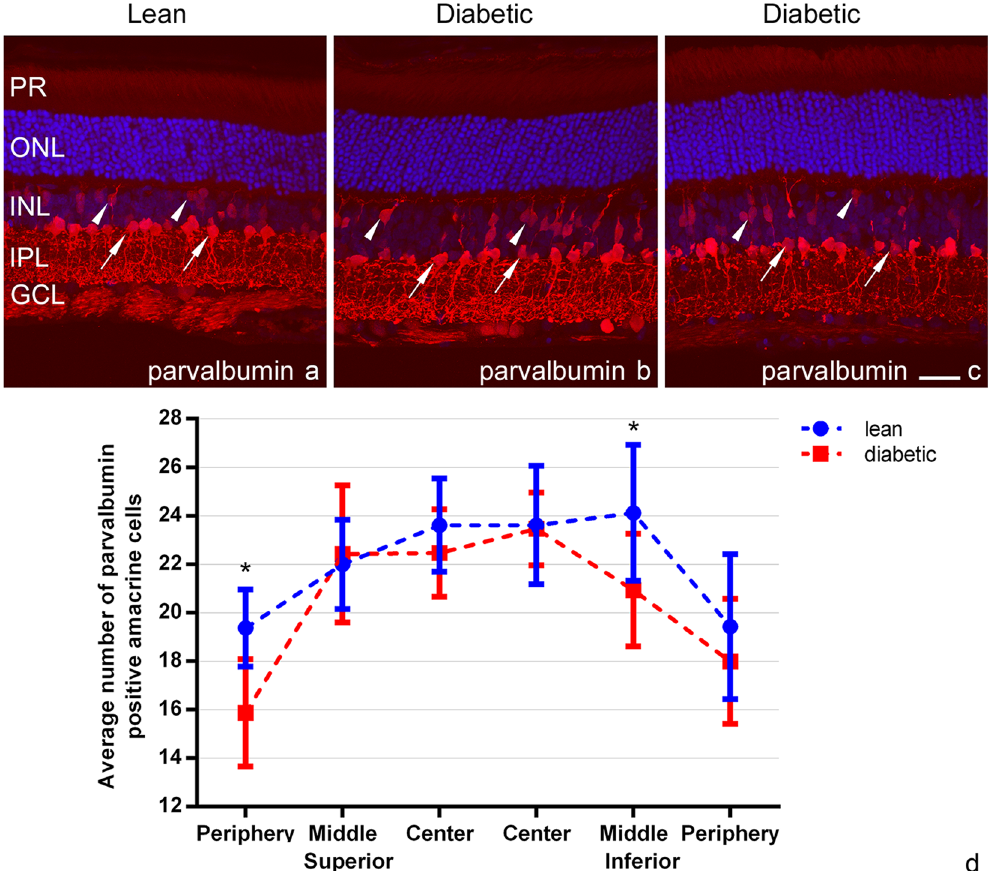
Figure 7. A decrease in the staining intensity and arborisation of parvalbumin stained AII amacrine cells. Parvalbumin (in red) stains mostly AII amacrine cells (arrows), a population of bipolar cells (arrowheads) and a few cells in the GCL. Compared to controls ( a ), there was a decrease in the staining intensity and arborisation of AII amacrine cells which was prominent in some regions ( c ), but less well visible in others ( b ). In most regions, there was no detectable change in the number of stained elements. Precise quantification ( d ) revealed a decrease only in the superior peripheral and inferior mid-peripheral regions ( * : p < 0.05). DAPI is used as a nuclear staining on a , b and c . PR: photoreceptor layer, ONL: outer nuclear layer, INL: inner nuclear layer, IPL: inner plexiform layer, GCL: ganglion cell layer. Bar : 20 μ